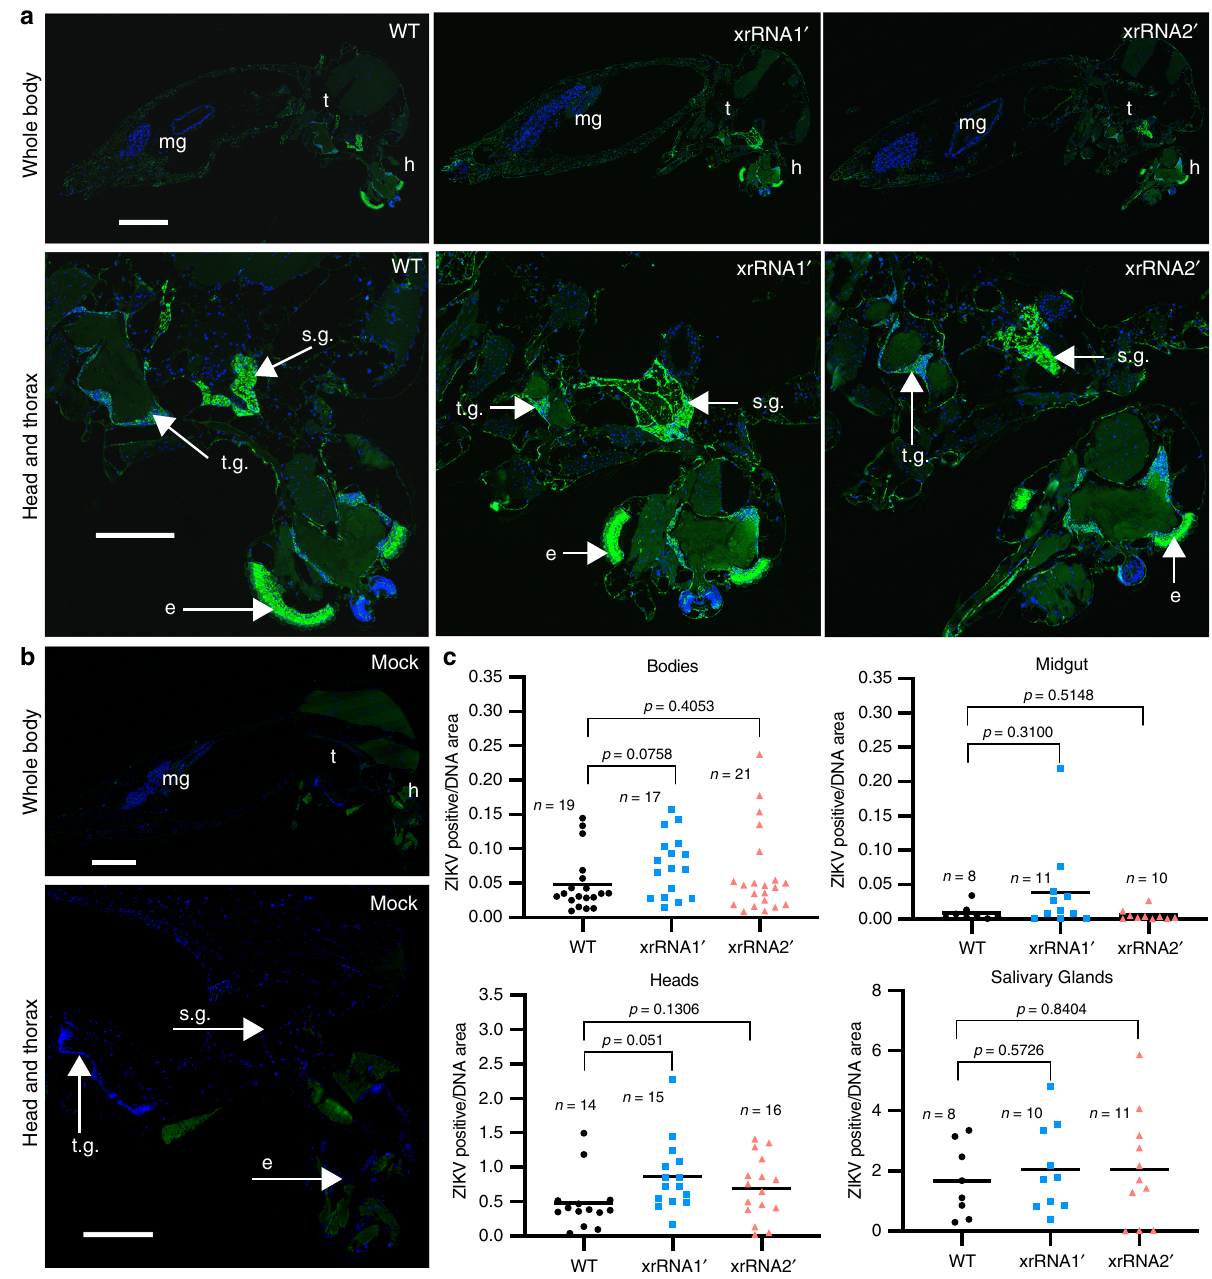
Fig. 3 sfRNA-de fi cient ZIKVs infect mosquito salivary glands. a Immuno fl uorescent detection of ZIKV NS1 (green) in histological sections of mosquitoes inoculated via i.t. injection and collected at 10dpi. Bottom panels show magni fi ed images of the major sites of viral replication in the head and thorax. Blue pseudo colour indicates for DAPI-stained nuclear DNA; mg, midgut; t, thorax; h, head; t.g., thoracic ganglia; s.g., salivary glands; e, eye. b Immuno fl uorescent staining of Mock-infected mosquitoes. c Quanti fi cation of ZIKV-infected areas in organs and tissues of mosquitoes. Statistical analysis was performed using Mann – Whitney U-test (independent comparisons, P -values are two-sided). Sample sizes, values for individual mosquitoes and the median (horizontal line) values for each group are shown. Images in ( a ) and ( b ) are representative microphotographs of 17 – 21 independent mosquitoes that showed similar results. Scale bars in ( a ) and ( b ) are 500 μ m (whole body) and 250 μ m (head and thorax), applicable to all images in corresponding